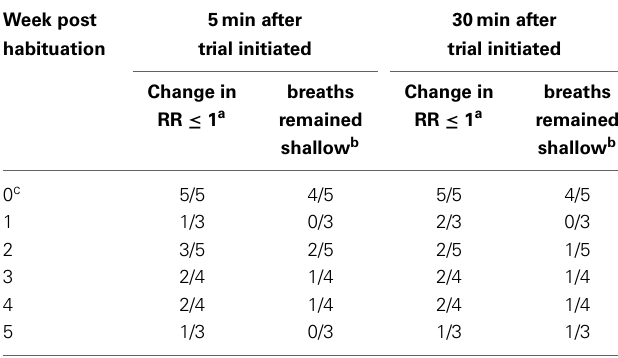
Table 1 | Retention of habituation behavior of Arctic Ground Squirrels (AGS) after habituation to handling and